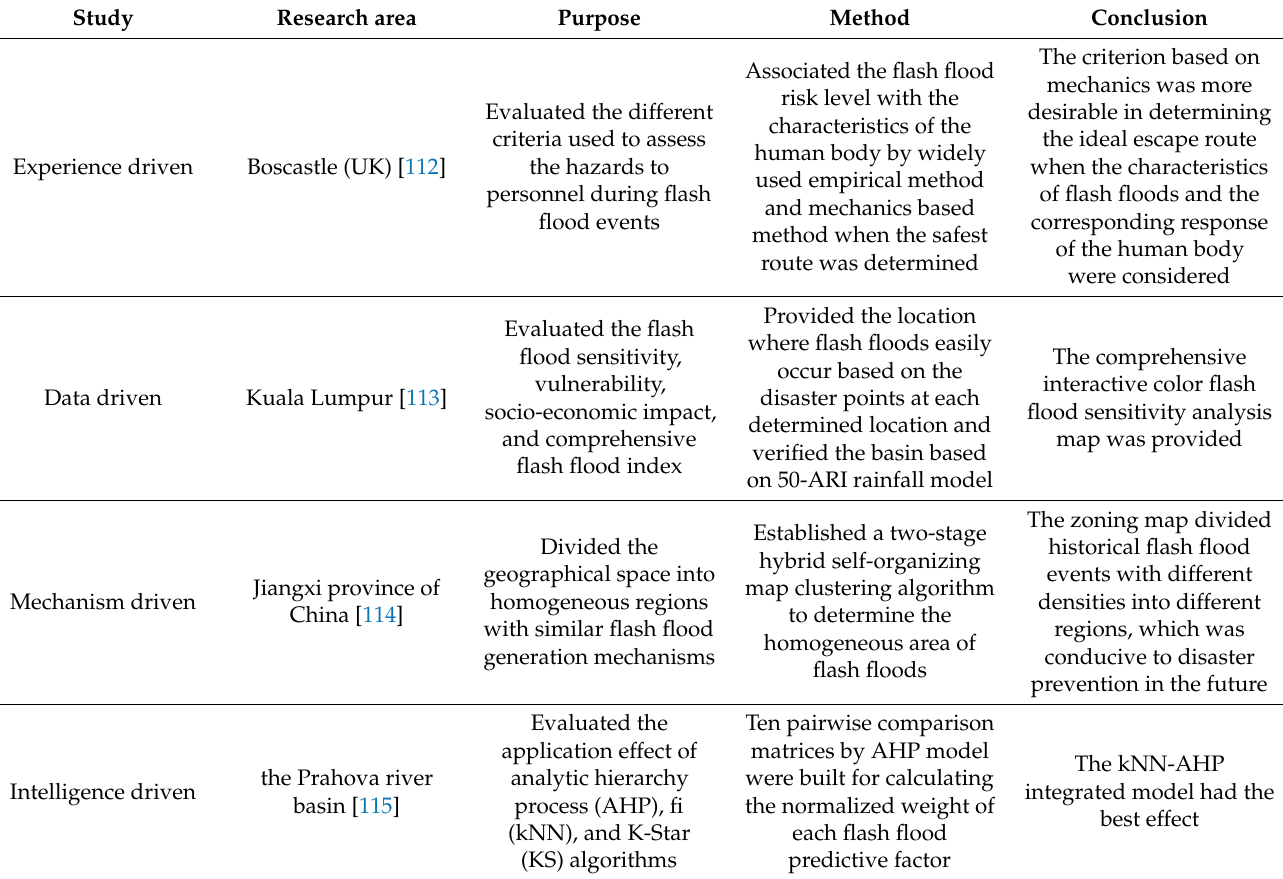
Table 5. Typical cases of sensitivity